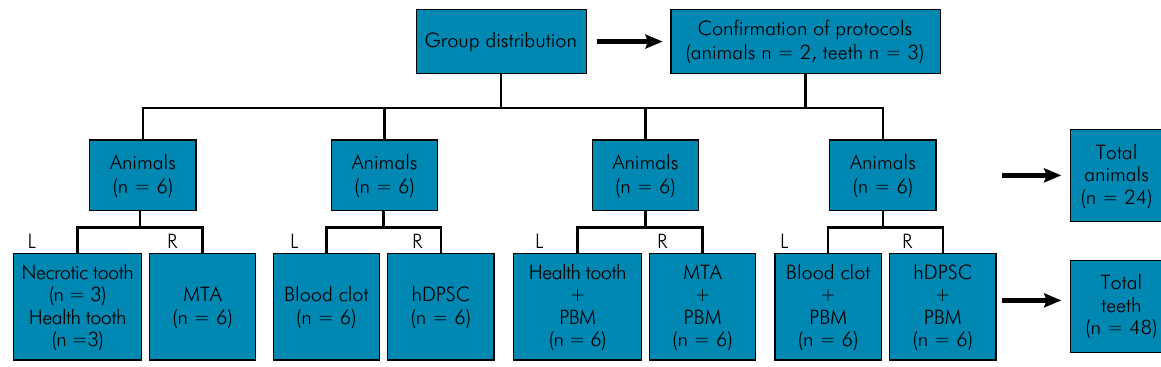
Figure 1. Flowchart illustrating group distribution according to the treatment protocols for rat